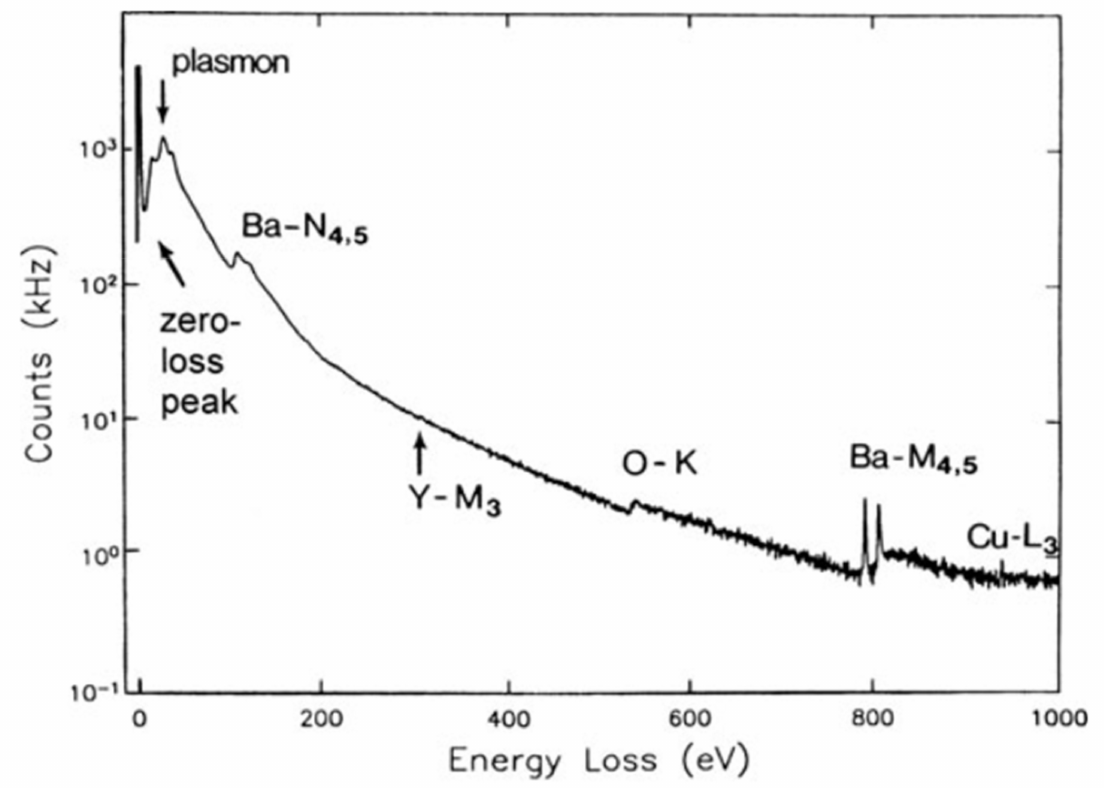
Figure 17. Electron energy loss spectrum (EELS) core loss edges of YBa 2 Cu 3 O 7 [142] . Figure 17 reprinted by permission from Springer Nature Customer Service Centre GmbH: Springer Nature, Springer eBook, An Introduction to EELS, R.F. Egerton, Copyright © 2011, Springer Science Business Media New